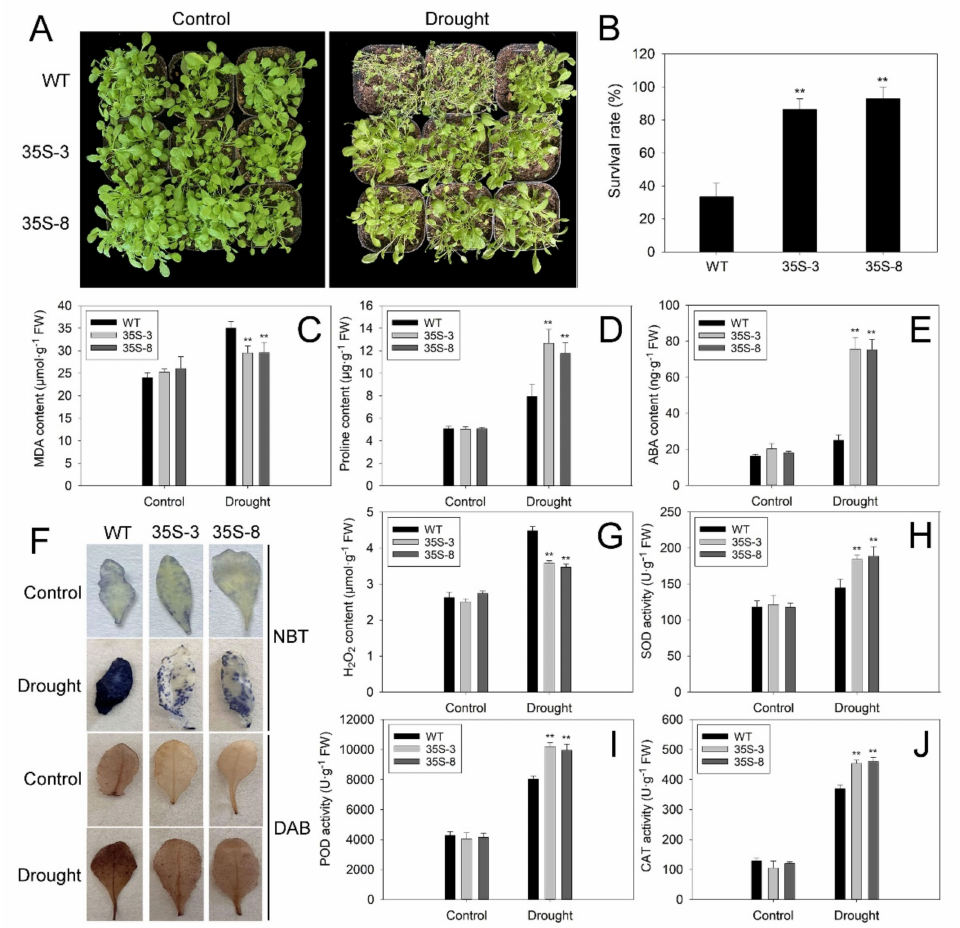
Figure 5. Drought tolerance analysis of the transgenic Arabidopsis ectopic-expressing PtrbHLH66 . ( A ) Phenotype, ( B ) survival rates, ( C ) leaf MDA, ( D ) proline and ( E ) ABA contents, ( F ) leaf NBT and DAB staining, ( G ) H 2 O 2 contents, ( H ) SOD, ( I ) POD and ( J ) CAT activities of the wild-type (WT) and transgenic seedlings were investigated under normal growth condition (control) and drought (withheld from watering for 3 weeks) stress. All data are shown as the means ± SD calculated from three biological replicates. Asterisks indicate that the values in transgenic Arabidopsis lines are significantly different from that of the WT plants (** p <